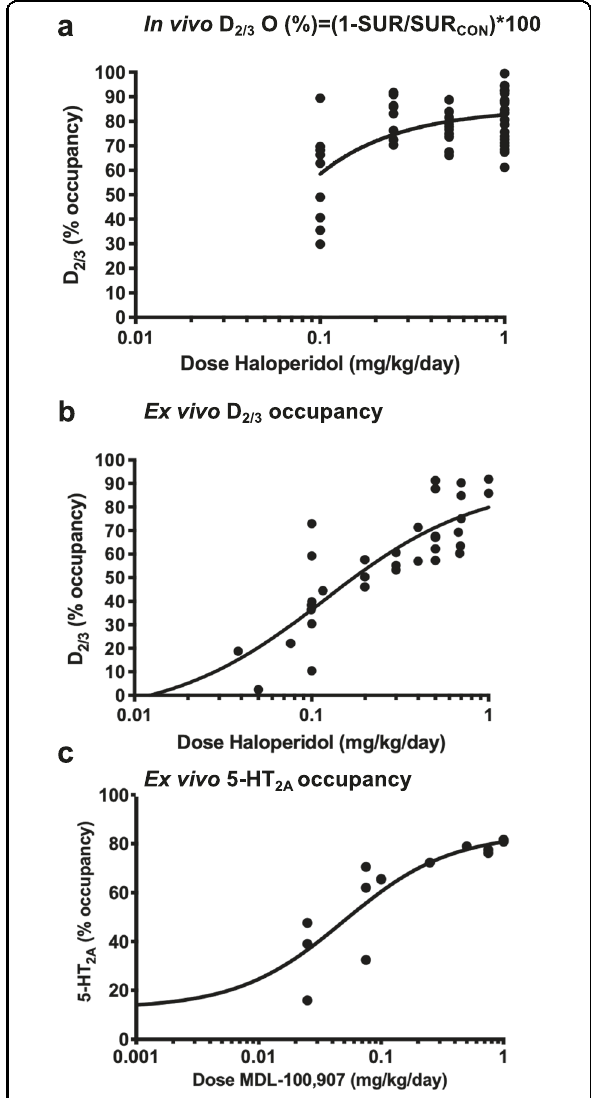
Fig. 2 Haloperidol and MDL-100,907 dose-occupancy curves. Fig. 2a and 2b shows the occupancy of the D 2/3 R in the striatum by various doses of haloperidol estimated in vivo and ex vivo, respectively. The equation used to calculate the occupancy is shown above Fig. 2a. Fig. 2c shows the occupancy of 5-HT2AR in the frontal cortex of rats by various doses of MDL-100,907, estimated ex